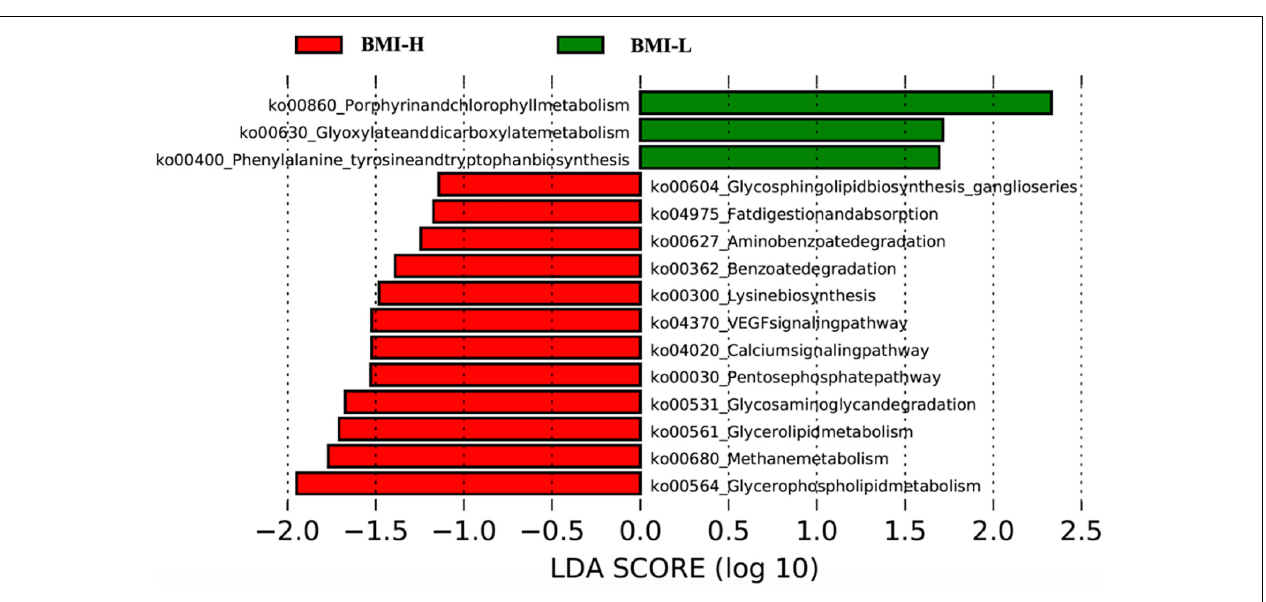
FIGURE 4 | Pathway clustering analysis based on LefSe classification showed that gut microbiota in different weight ranges expressed different metabolic pathways. The gut microbiota of patients with high BMI can express more pathways related to disordered glucose and lipid